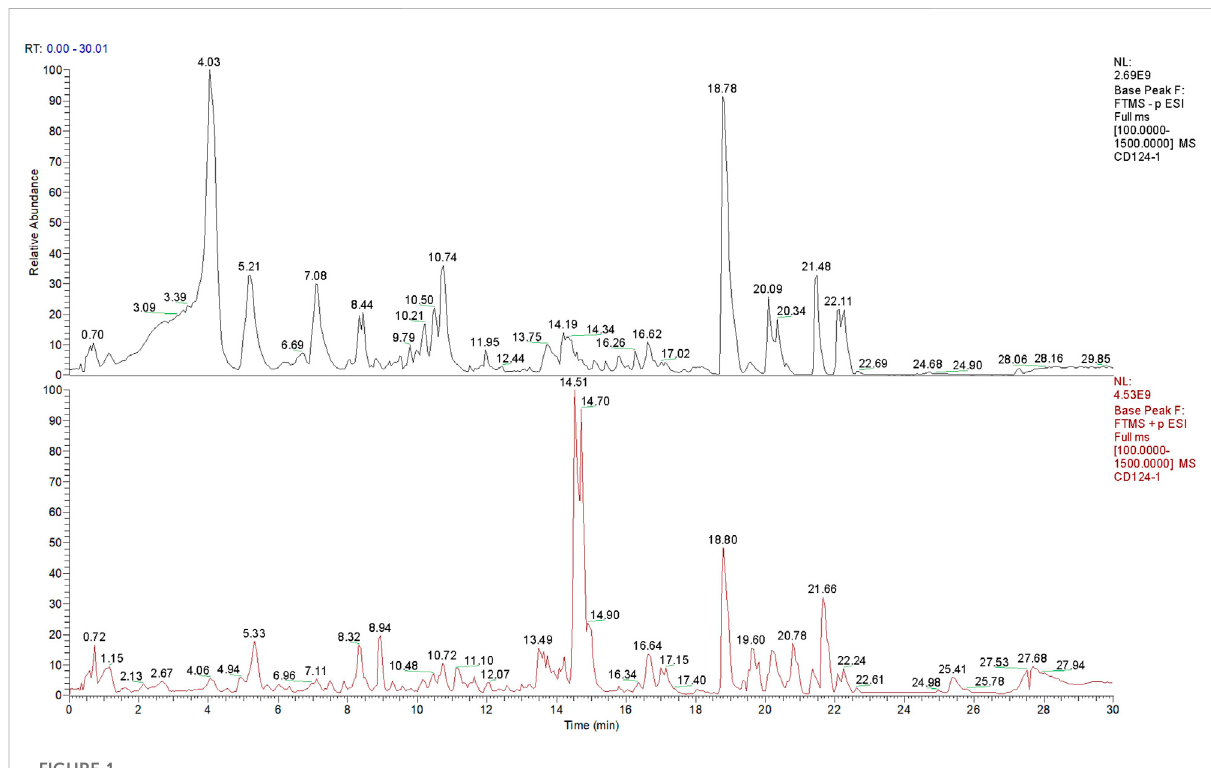
FIGURE 1 Total ion fl ow diagram of